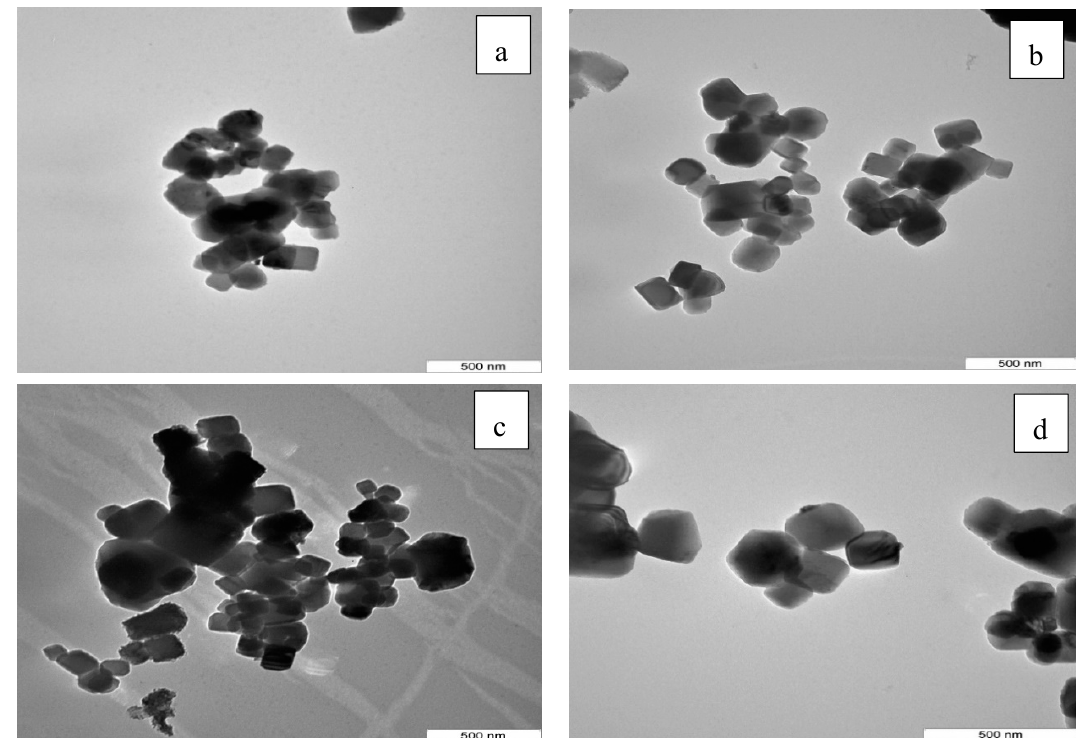
Figure 5. TEM images of catalysts: ( a ) Pt,Pd,Ni / MgO, ( b ) Pt,Pd,Ni / Mg 0.97 La 3 + 0.03 O, ( c ) Pt,Pd,Ni / Mg 0.93 La 3 + 0.07 O, ( d ) Pt,Pd,Ni / Mg 0.85 La 3 + 0.15 O.